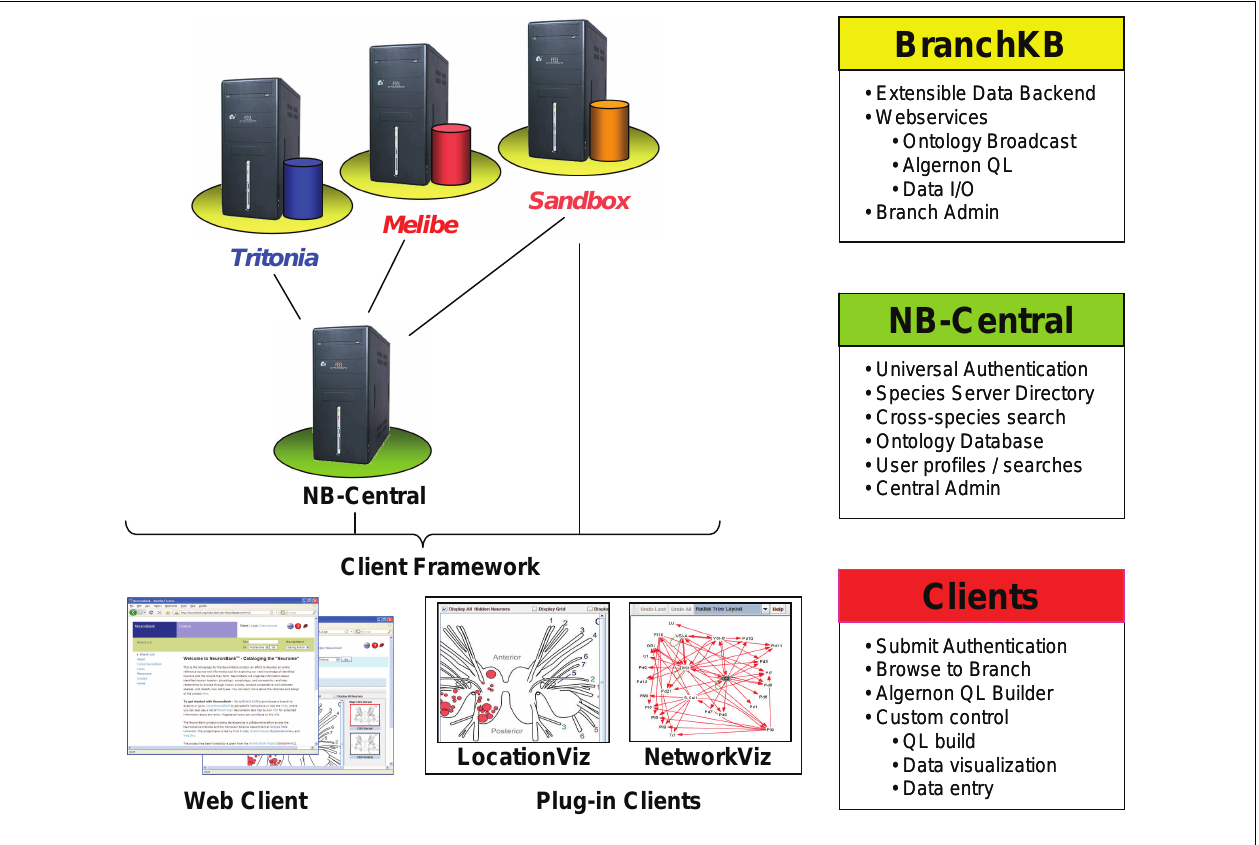
FIGURE 2 | Architecture of